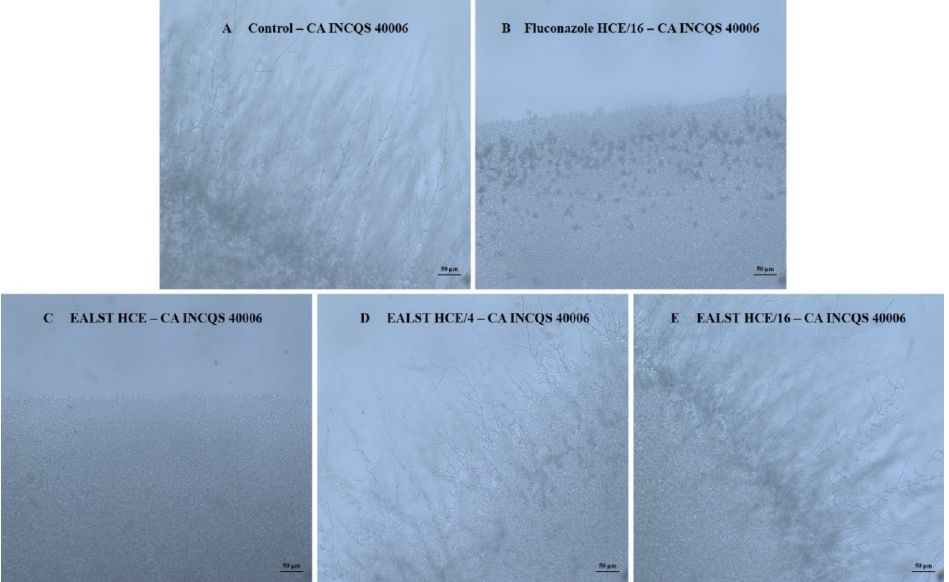
Figure 4. Demonstrative effect of EASTL and fluconazole on the morphological transition of Candida albicans . CA: Candida albicans ; INCQS: National Institute of Quality Control in Health; EALST: Extract Aqueous of Spondias tuberosa leaves; FCZ: Fluconazole; HCE: Highest Concentration Evaluated. ( A ) Growth control, presence of filamentous structure; ( B ) Fluconazole control in HCE/16 concentration; ( C ) Effect of EALST on morphological transition in HCE concentration; ( D ) Effect of EALST on morphological transition in HCE/4 concentration; ( E ) Effect of EALST on morphological transition in HCE/16 concentration.